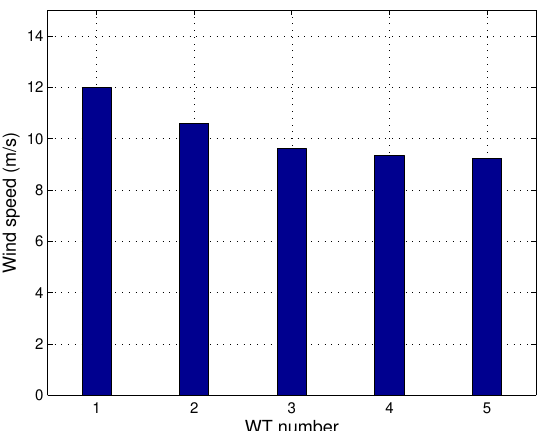
Figure 6. Distribution of the wind speed of the five-WT wind farm with a 6.5- D spacing.